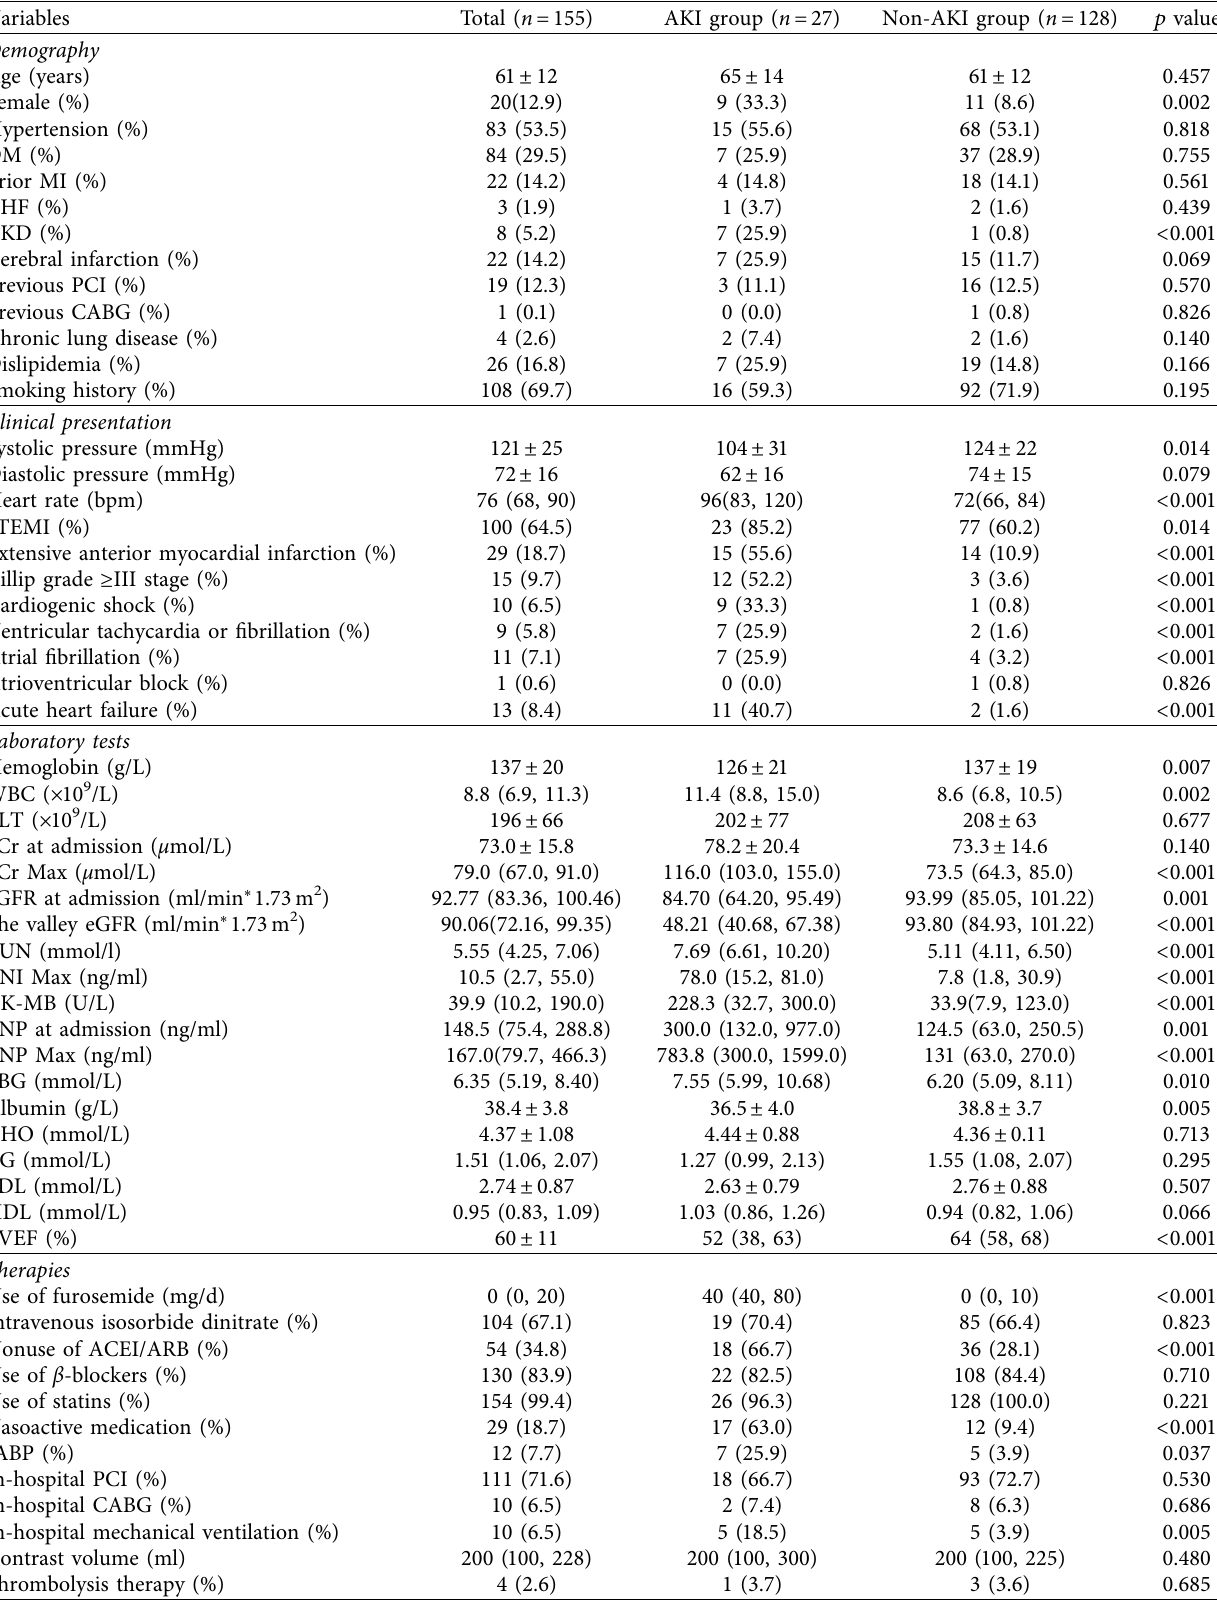
Table 1: Baseline characteristics in AMI patients with or without